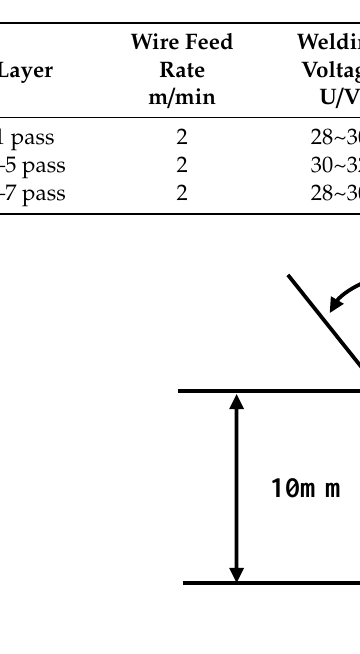
Table 5. Mass fraction of test powder (mass, wt %)